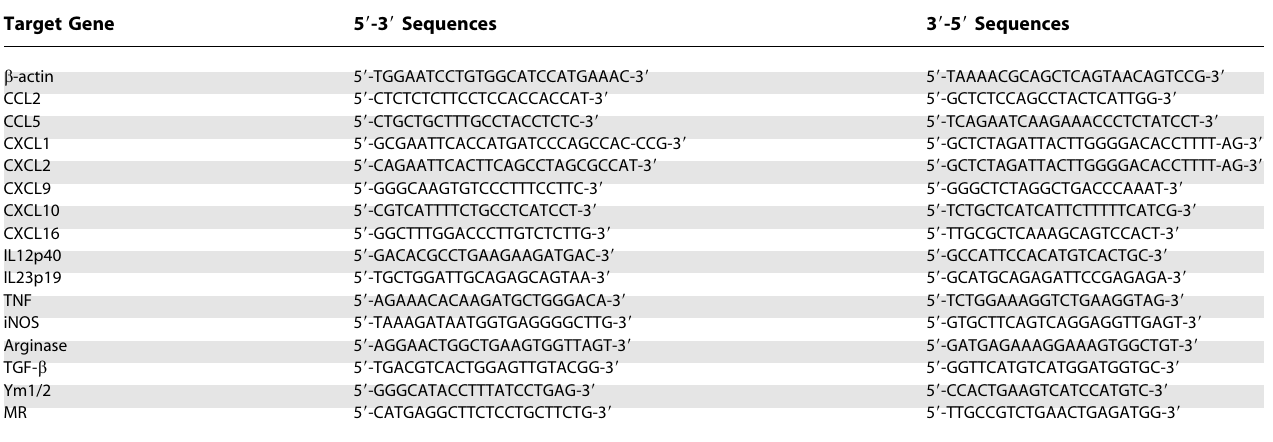
Table 1. Nucleotide Sequences of Oligonucleotide Primers Target